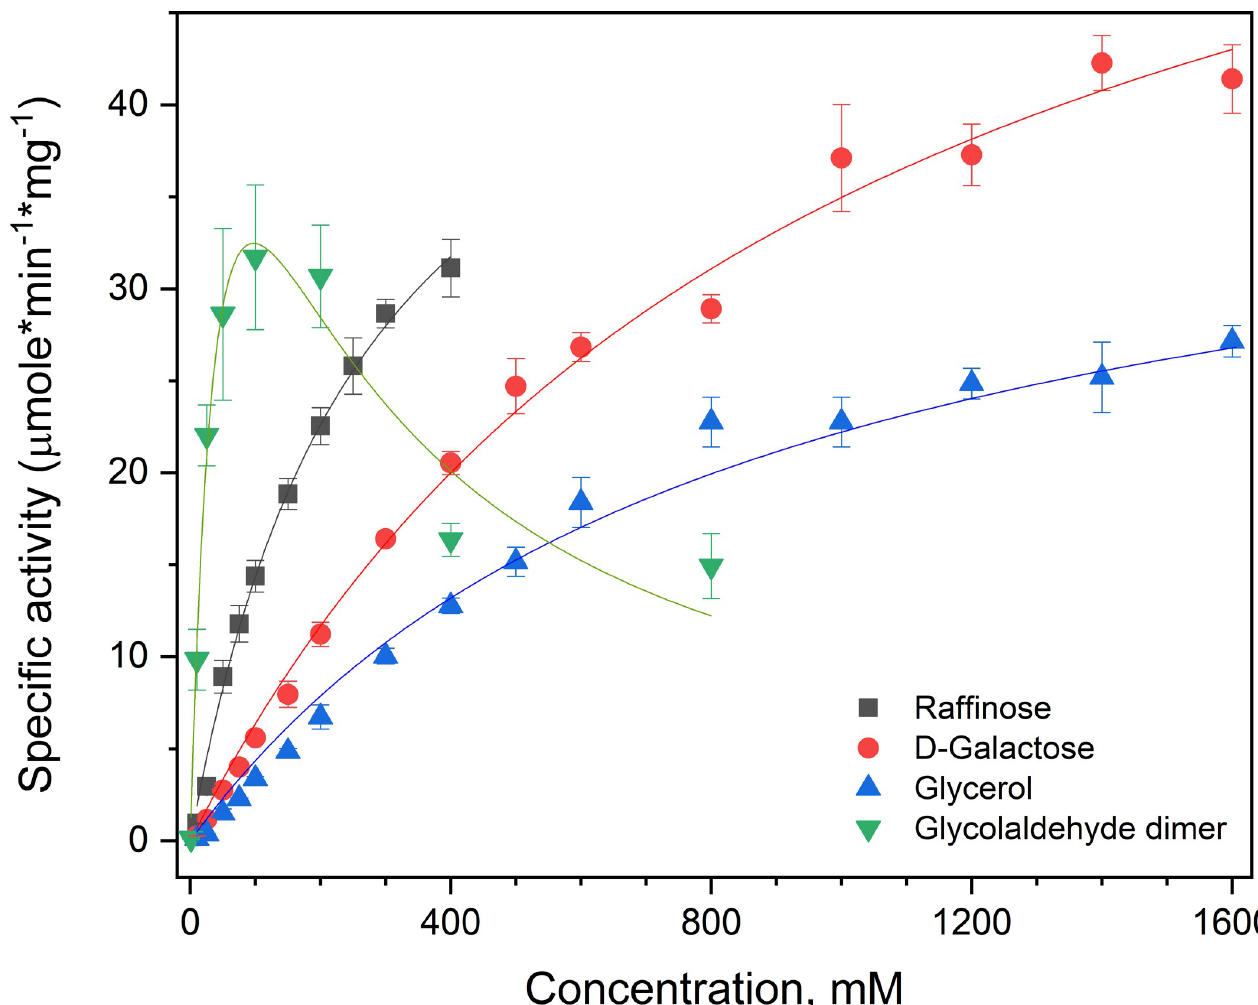
Fig 6. Kinetic analysis of Pru AA5_2A on preferred substrates. Raffinose ( ■ ), galactose (•), glycerol ( ▲ ) and a fresh solution of glycolaldehyde dimer ( ▼ ). n = 4; error bars indicate standard deviations. The data were fitted to the Michaelis-Menten or substrate-inhibition (glycolaldehyde dimer) functions using the OriginPro analysis software (iteration algorithm: Levenberberg-Marquardt); in all cases R 2 values were > 0.95. For all substrates besides the glycolaldehyde dimer, saturation kinetics were not achieved below substrate solubility. Accordingly, apparent kinetic parameters are reported.